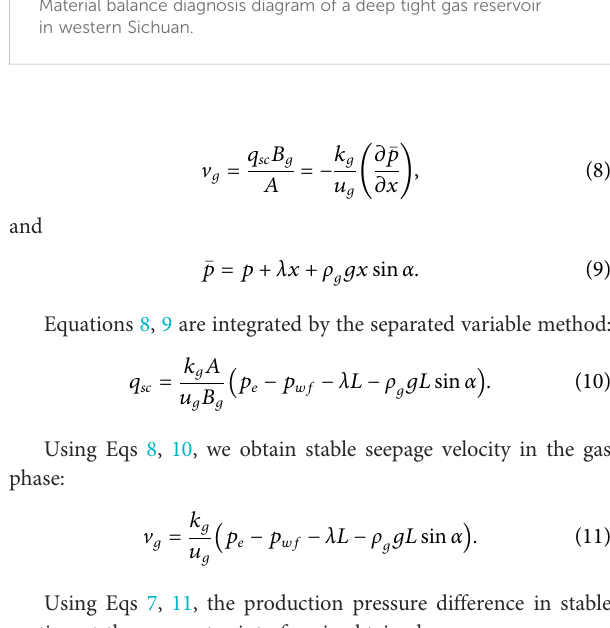
FIGURE 5 Material balance diagnosis diagram of a deep tight gas reservoir in western